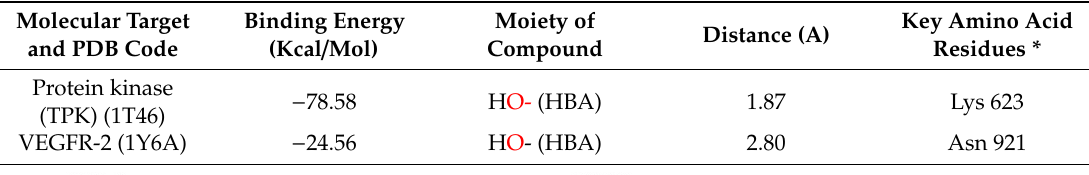
Table 3. Ligand receptor interactions of compound 1 # inside the tyrosine-specific protein kinase (TPK) (1T46) and vascular endothelial growth factor receptor (VEGFR-2) (1Y6A) targets. PDB: Protein Data Bank.